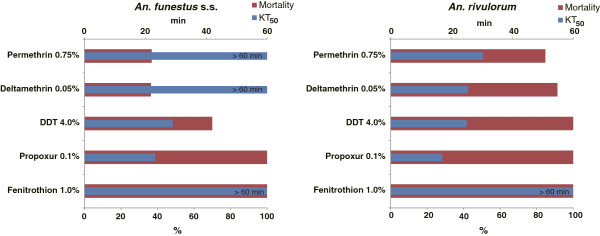
Insecticide susceptibility of An. funestus F1 females. Insecticide susceptibility of unfed female F1 adult mosquitoes in An. funestus s.l. determined by the World Health Organization tube test.